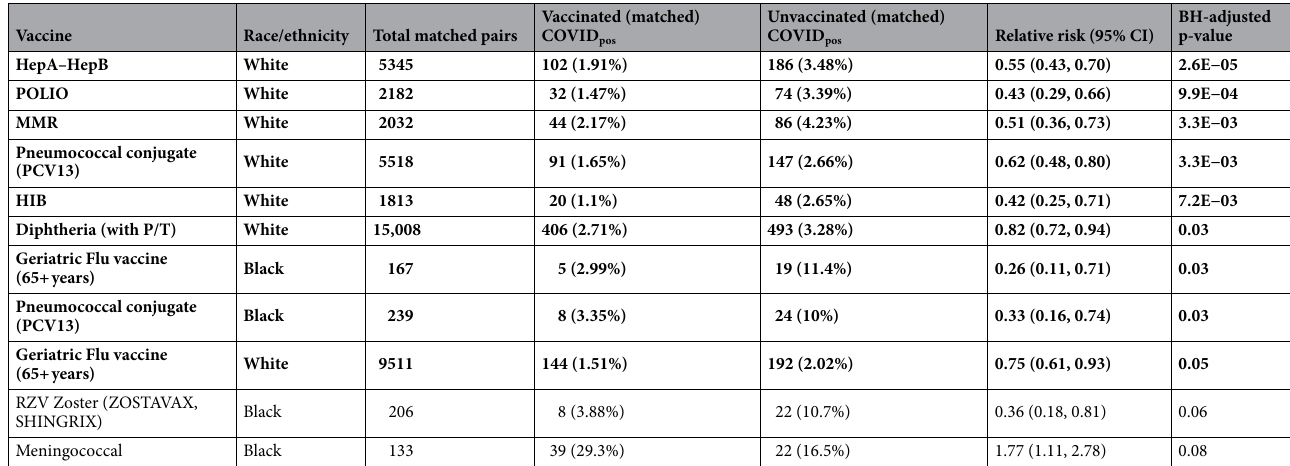
Table 8. Summary of SARS-CoV-2 rates for race/ethnicity-stratified vaccinated and unvaccinated propensity score matched cohorts (2 year time horizon). Table of SARS-CoV-2 infection rates for vaccinated and unvaccinated (matched) race/ethnicity subgroup cohorts for vaccines administered within 2 years prior to PCR testing. Only rows with adjusted p-values ≤ 0.1 are included. Rows in which the SARS-CoV-2 rate is lower (adjusted p-value < 0.05) in the vaccinated cohort are highlighted in bold. The columns are (1) Vaccine: Name of the vaccine, (2) Race/ethnicity: Race/ethnicity subgroup, (3) Total matched pairs: Number of pairs from the propensity matching procedure, which is the sample size of both vaccinated and unvaccinated cohorts after matching, (4) Vaccinated (matched) COVID pos : Number of COVID pos cases among the vaccinated (matched) cohort, along with the percentage in parentheses, (5) Unvaccinated (matched) COVID pos : Number of COVID pos cases among the unvaccinated (matched) cohort, along with the percentage in parentheses, (6) Relative risk (95% CI): Relative risk of COVID pos in the vaccinated (matched) cohort compared to